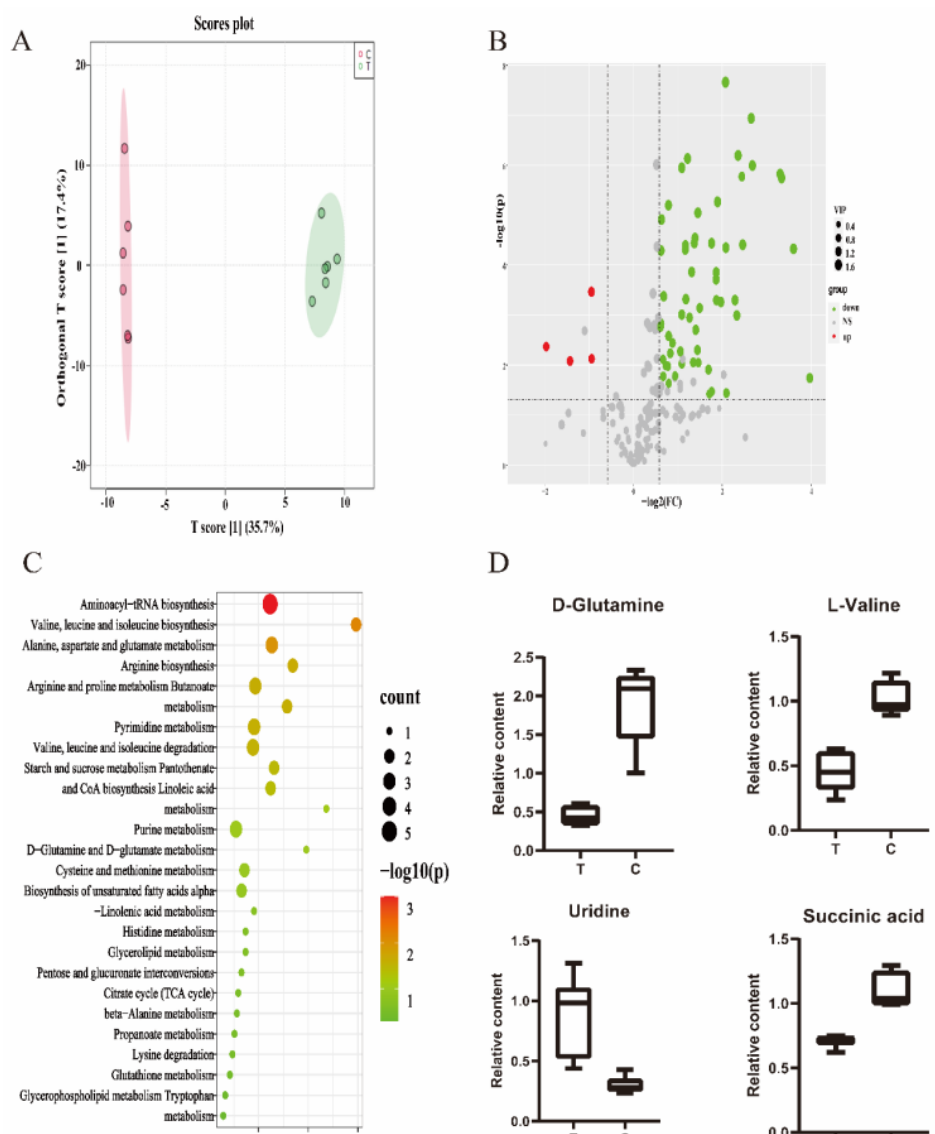
Figure 4. Data analysis of metabonomics. ( A ): OPLS-DA analysis. ( B ): Volcano map of all metabolites detected. ( C ): KEGG enrichment analysis. ( D ): Differences in the content of some differential metabolites between the control group and CEO-treated group.